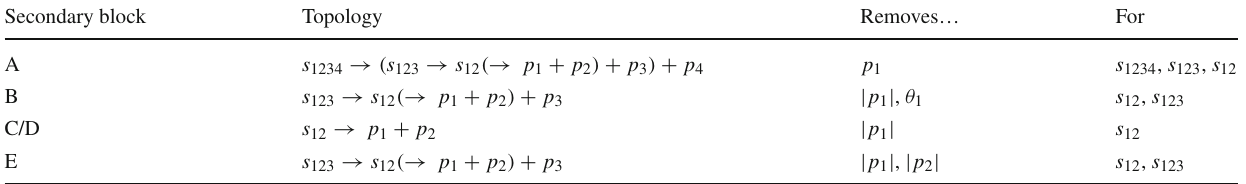
Table 2 Set of MoMEMta Secondary Blocks. Each block performs a specific change of integration variables, acting exclusively on final- state particles. The third and fourth columns show the integration vari- ables respectively removed and introduced by each change of variables.